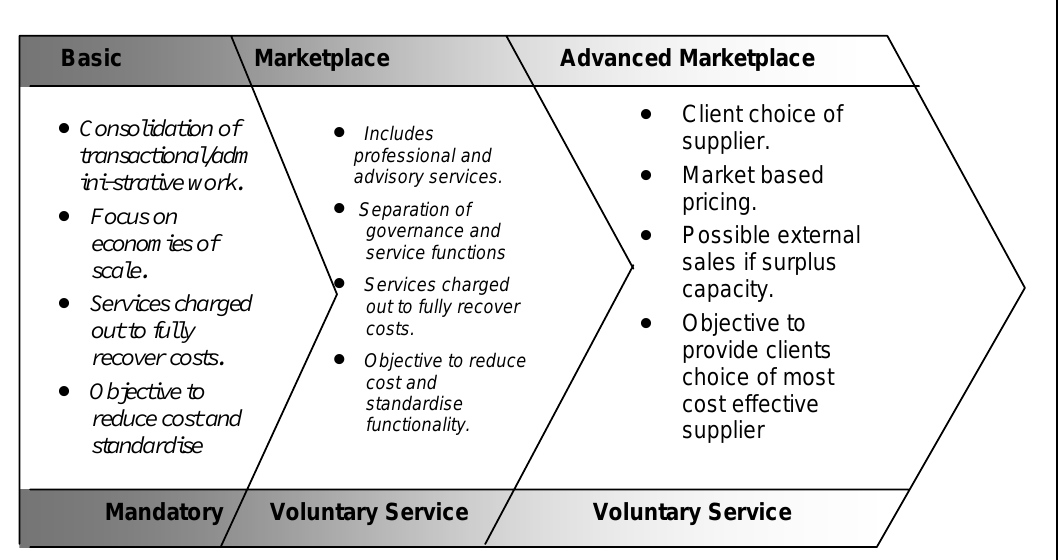
Figure 4: Shared services – the advanced marketplace